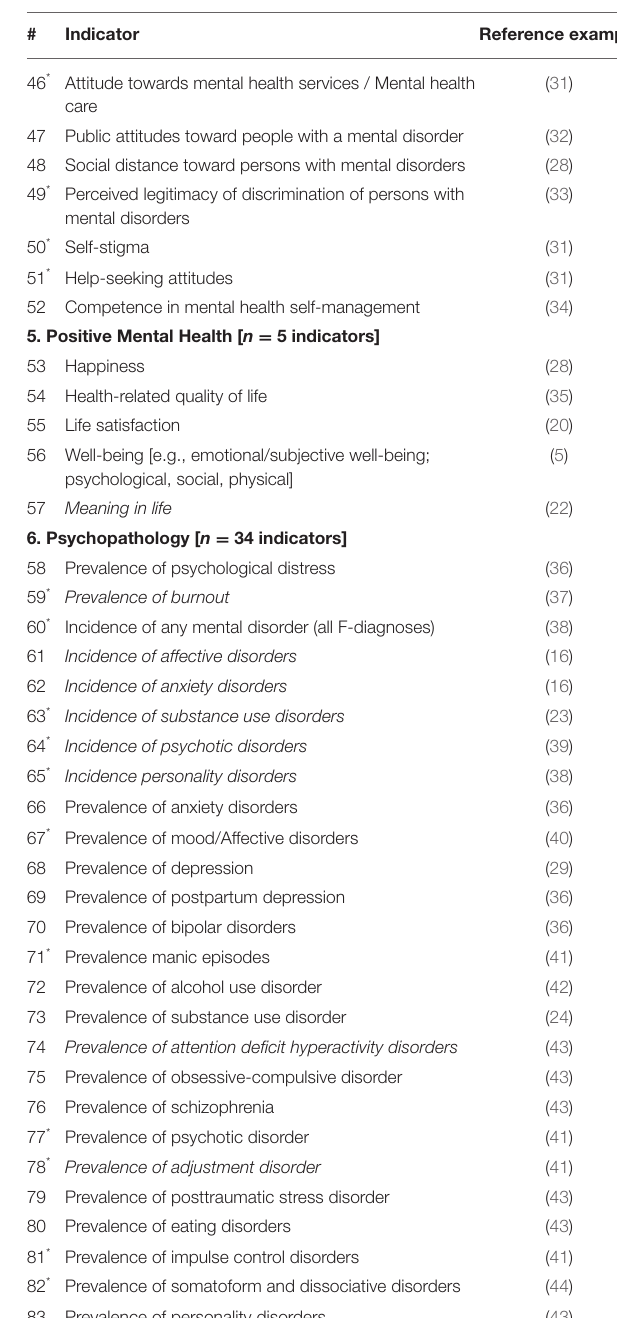
TABLE 1 | Indicators of public mental health in OECD